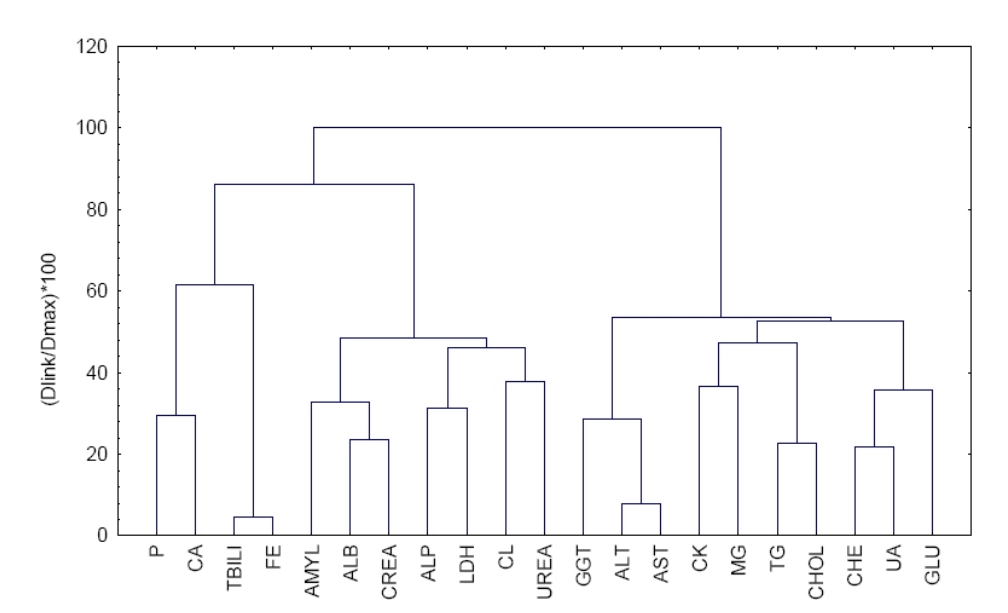
Fig. 3 Hierarchical dendrogram for 21 clinical parameters of female healthy individuals ( N =